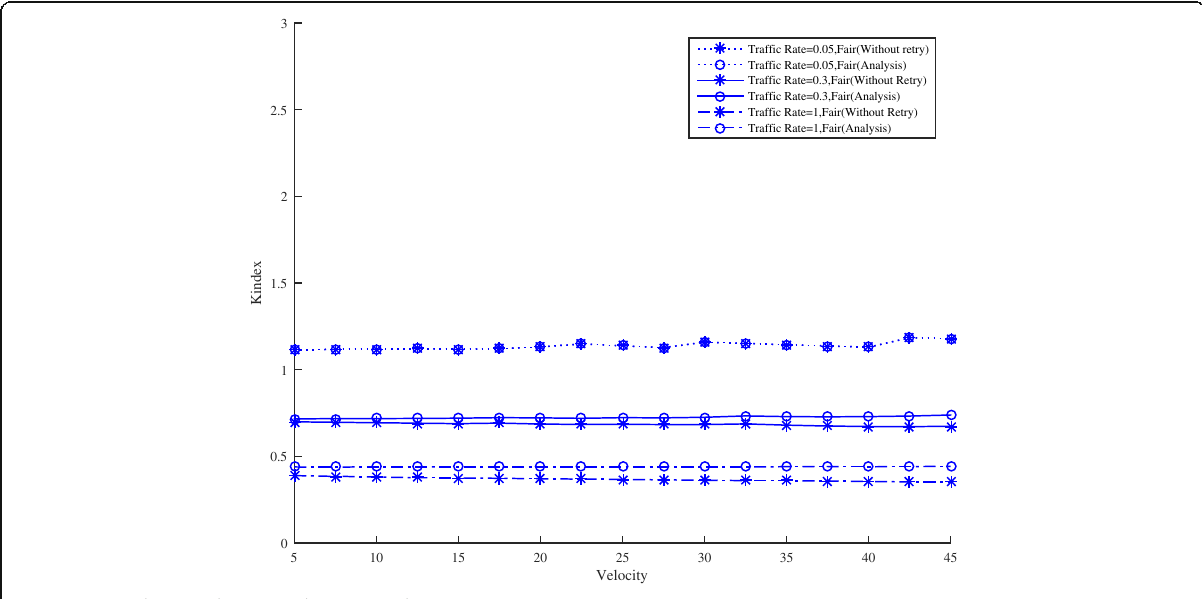
Fig. 6 K index with a retry limit vs without a retry